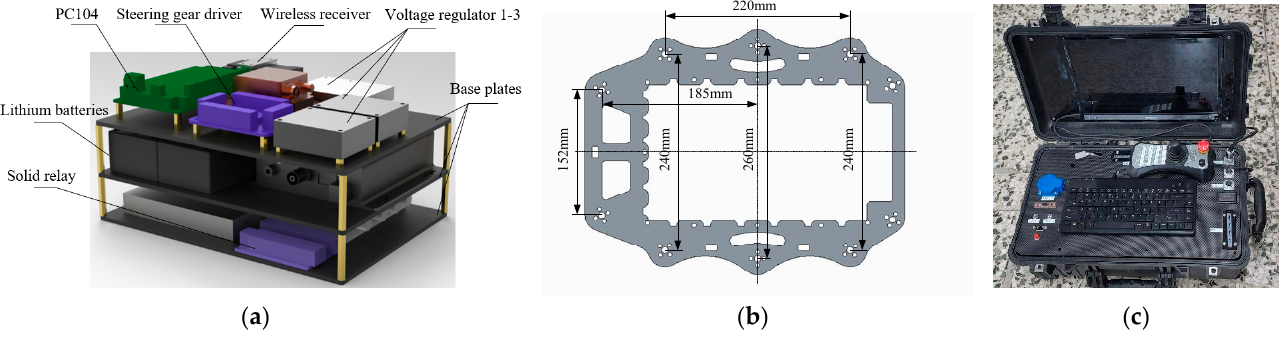
Figure 6. The three-dimensional model. ( a ) is the control module and power unit. ( b ) is the fiber plastic frame boards. ( c ) is the control platform.